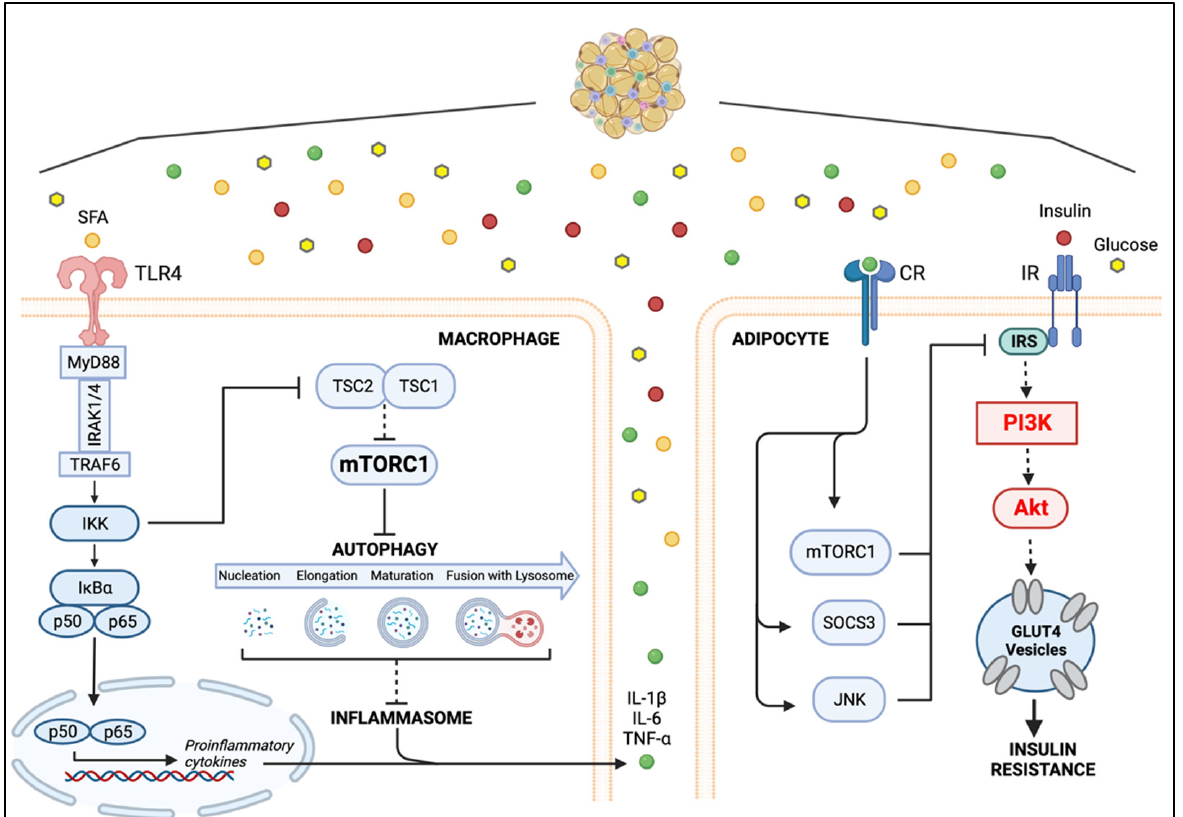
Figure 3. The Macrophage–Adipocyte Crosstalk in Metabolically challenged Adipose Tissue. Activation of macrophage TLR4 by SFAs induces the expression of proinflammatory cytokines, such as IL-1 β , IL-6 and TNF- α . Binding of proinflammatory cytokines to their corresponding receptors on adipocytes induces the expression of SOCS3 and activates JNK and mTORC1. Stimulation of SOCS3 leads to proteasomal degradation of IRS1. Activated JNK and mTORC1 block IRS1 downstream signaling by promoting phosphorylation of inhibitory serine residues on IRS1. The concomitant insulin signaling inhibition promotes the establishment of insulin resistance in the AT. (Created with BioRender.com on 19 October 2022). Abbreviations: SFAs, saturated fatty acids; TLR4, Toll-like receptor 4; MyD88, myeloid differentiation factor 88; IRAK1/4, IL-1 receptor-associated kinase 1 and 4; TRAF6, tumor necrosis factor receptor associated factor 6; IKK, I κ B kinase; I κ B, inhibitor κ B